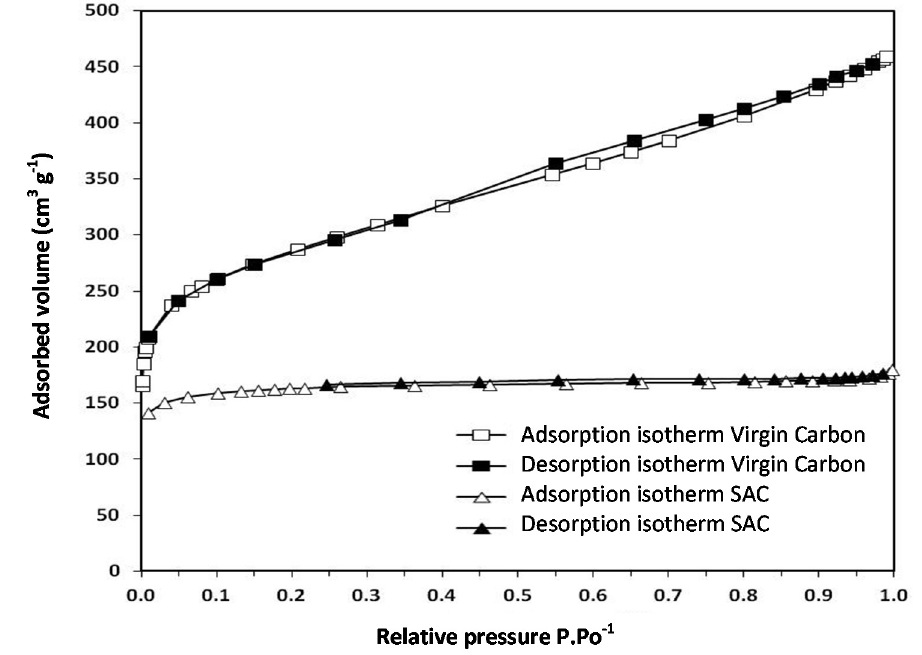
Figure A2. N 2 adsorption–desorption isotherms of virgin carbon and SAC.